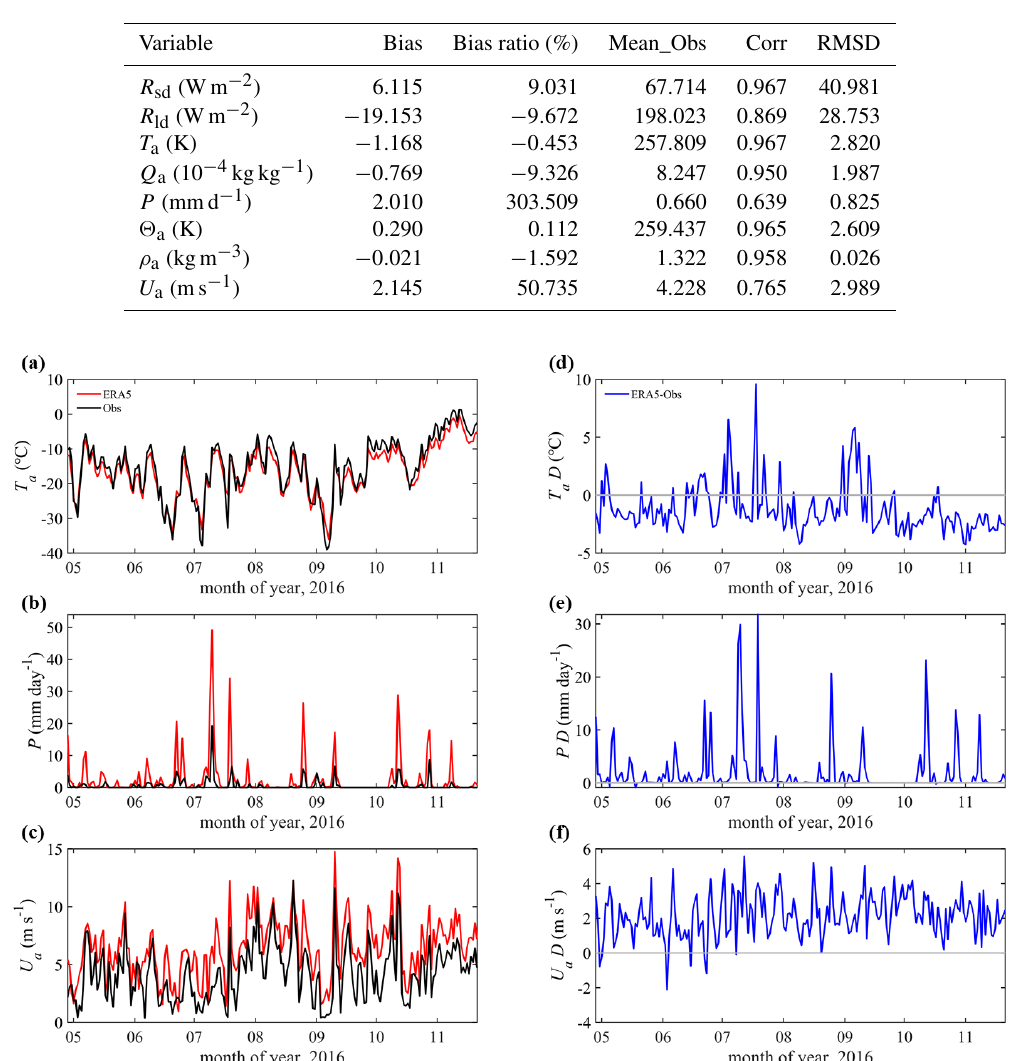
Figure 2. Time series of daily (a) surface air temperature, (b) precipitation rate, and (c) wind speed (10m above the surface). The ERA5 reanalysis data are indicated as red lines. Observations are marked by black lines. Panels (d–f) show the difference (marked by “ D ”) between ERA5 and the observations (ERA5-observation). The differences are marked by blue lines. The gray lines denote the zero